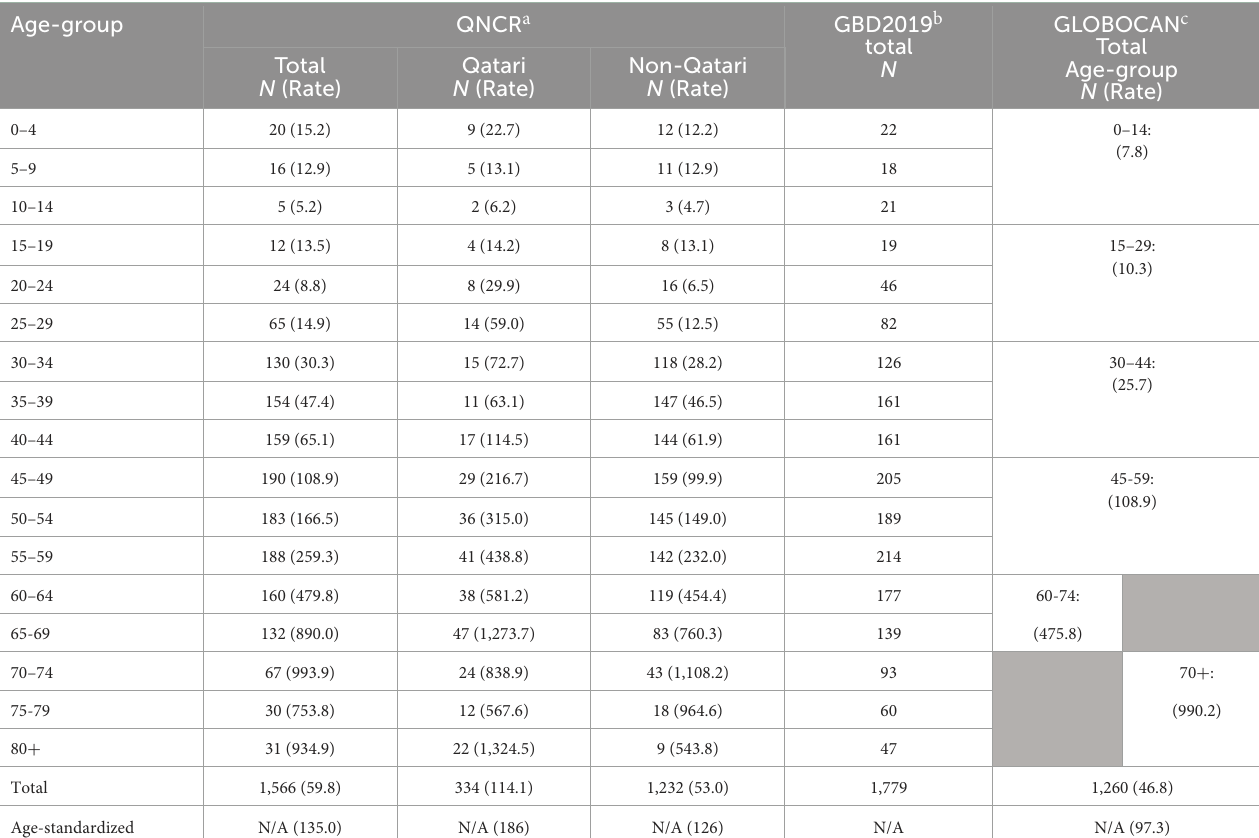
TABLE 3 Incidence rates of cancers in Qatar based on Qatar National Cancer Registry (QNCR) and estimations of GBD 2019 and GLOBOCAN 2018.